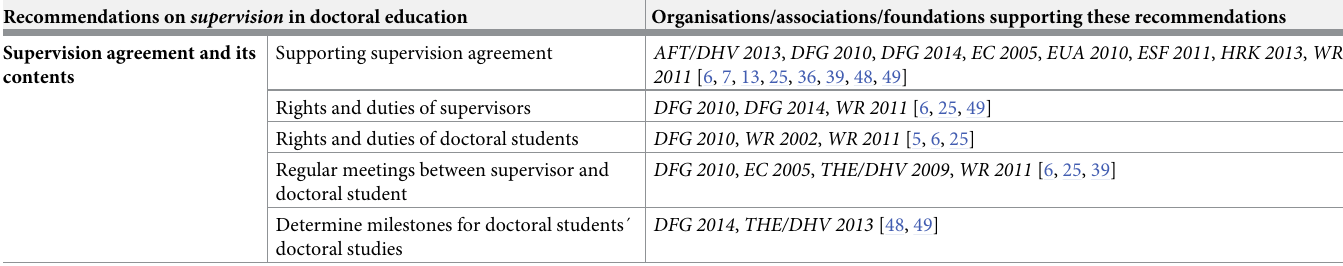
Table 5. Recommendations on supervision in doctoral